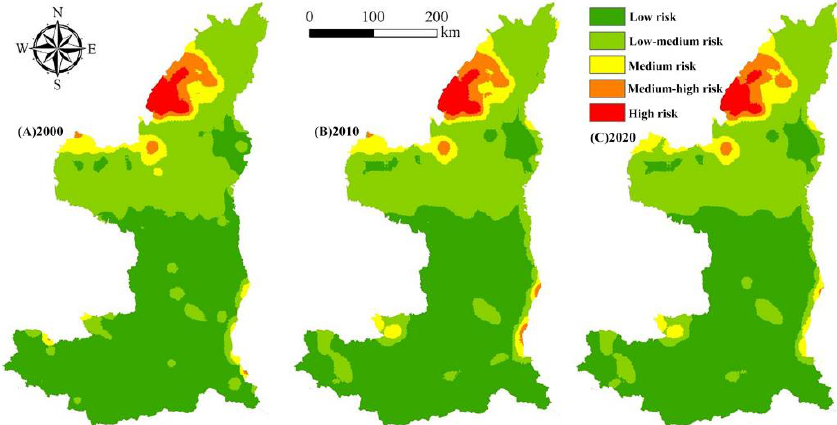
Figure 5. Spatial distribution changes in landscape ecological risk areas in the Yellow River Basin, Shaanxi Province from 2000 to 2020.